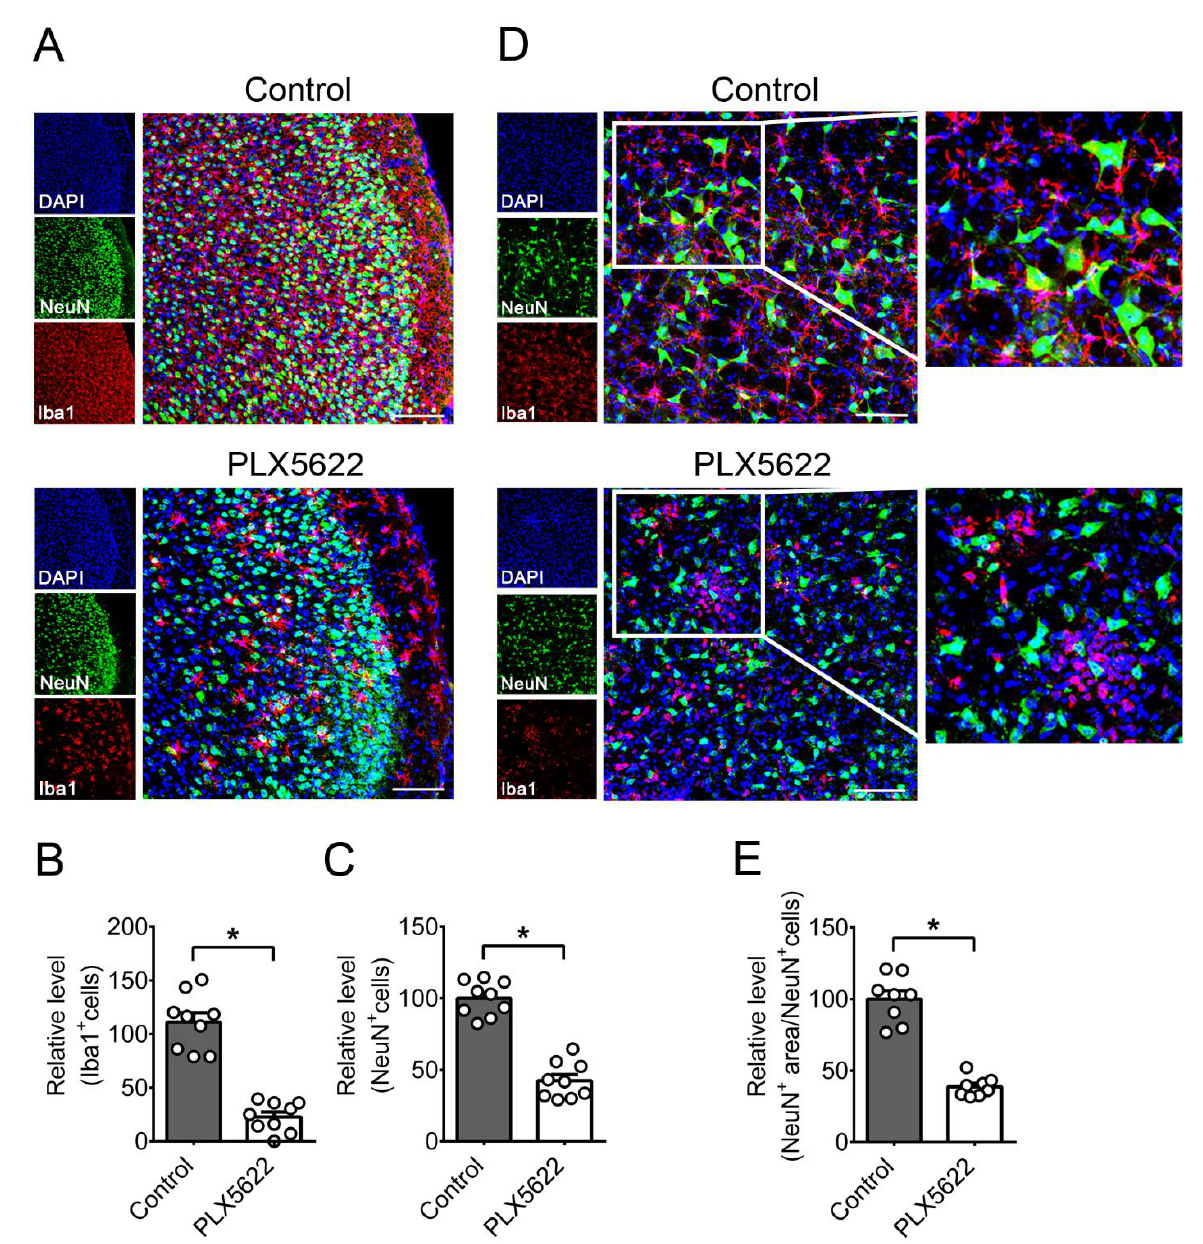
Figure 3. The effects of PLX5622 on the microglia and neurons in brains of infected mice. Sections of brains from infected mice fed with control chow or the chow containing PLX5622 were harvested on day 7 post-infection and subjected to immunofluorescence staining with antibodies against mouse NeuN or Iba1. The results of ( A – C ) temporal lobe and ( D , E ) brain stem regions are shown. Scale bar, 50 μm. In panel ( A ), right panels are the merged and magnified images of three left panels. In panel ( D ), middle panels are the merged and magnified images of three left panels, and right panels are the magnified images of indicated areas shown in middle panels. ( B ) Iba1 + , ( C ) NeuN + cells, and ( E ) NeuN + area/NeuN + cells in the mouse temporal lobe in images (0.15 × 0.15 mm) were quantified. The means of control groups were set as 100%. The data represent means + SEM (error bars) of 3 mice per group obtained from at least two independent experiments with three or two sections per mouse. *, p < 0.05.